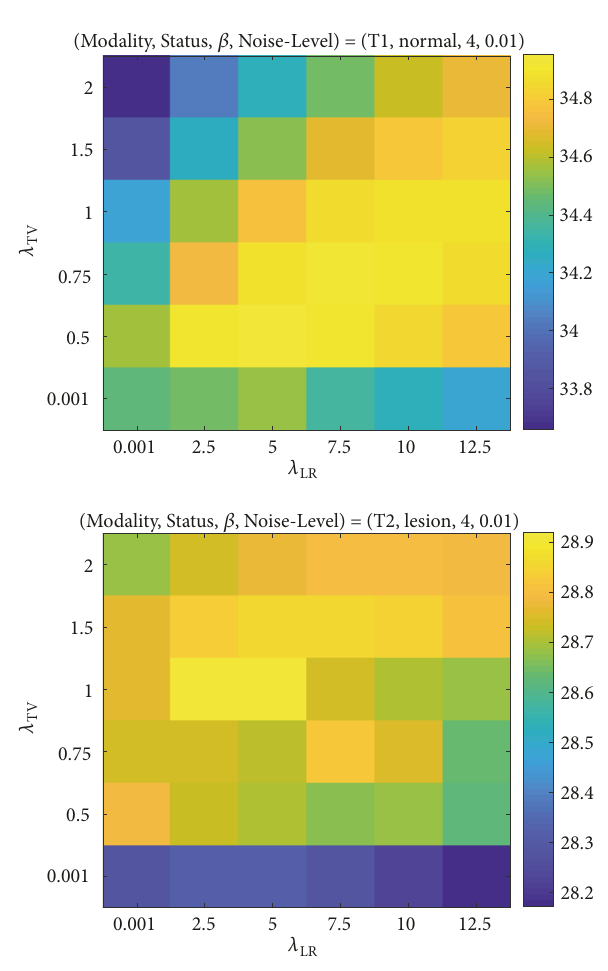
Figure 4: Examples of PSNR results of the proposed method when 𝜆 𝜆 TV and LR are simultaneously changed. The input images were images (a) and (m) in Table